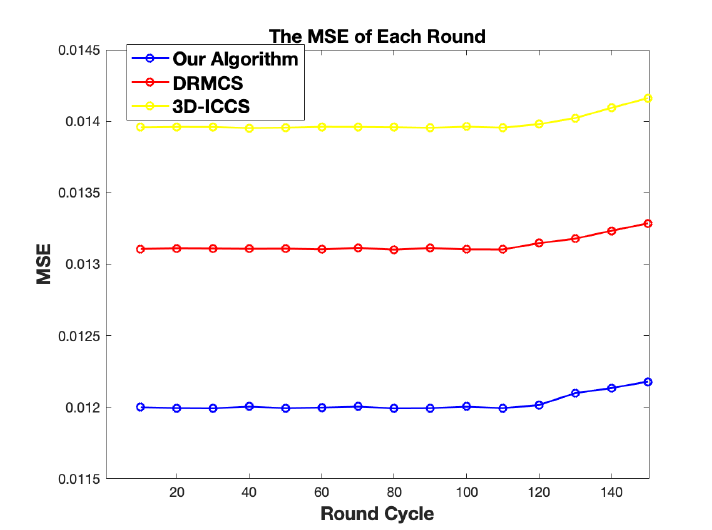
Figure 12. The comparison results in terms of data recovery qualities.